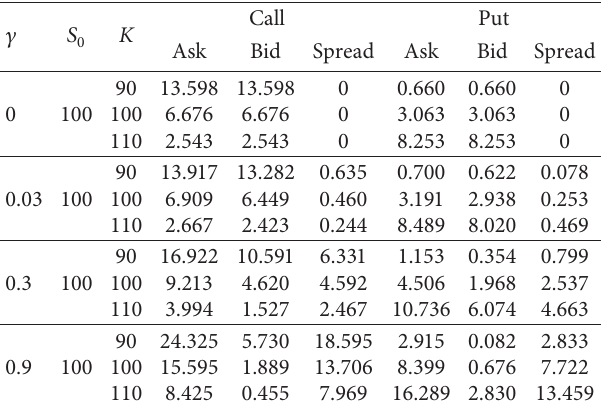
Table 2: The bid-ask prices of the European discrete